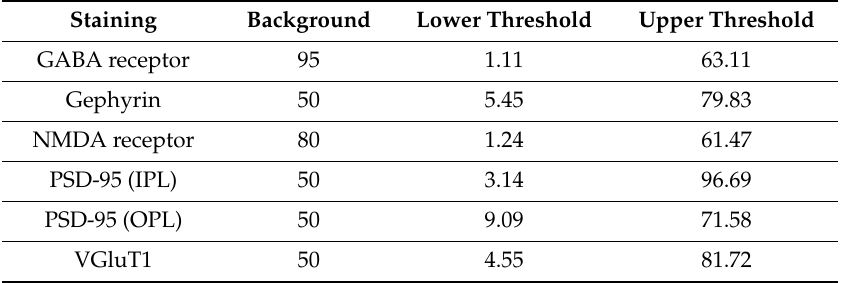
Table 2. Background subtraction as well as lower and upper thresholds used for staining analysis.